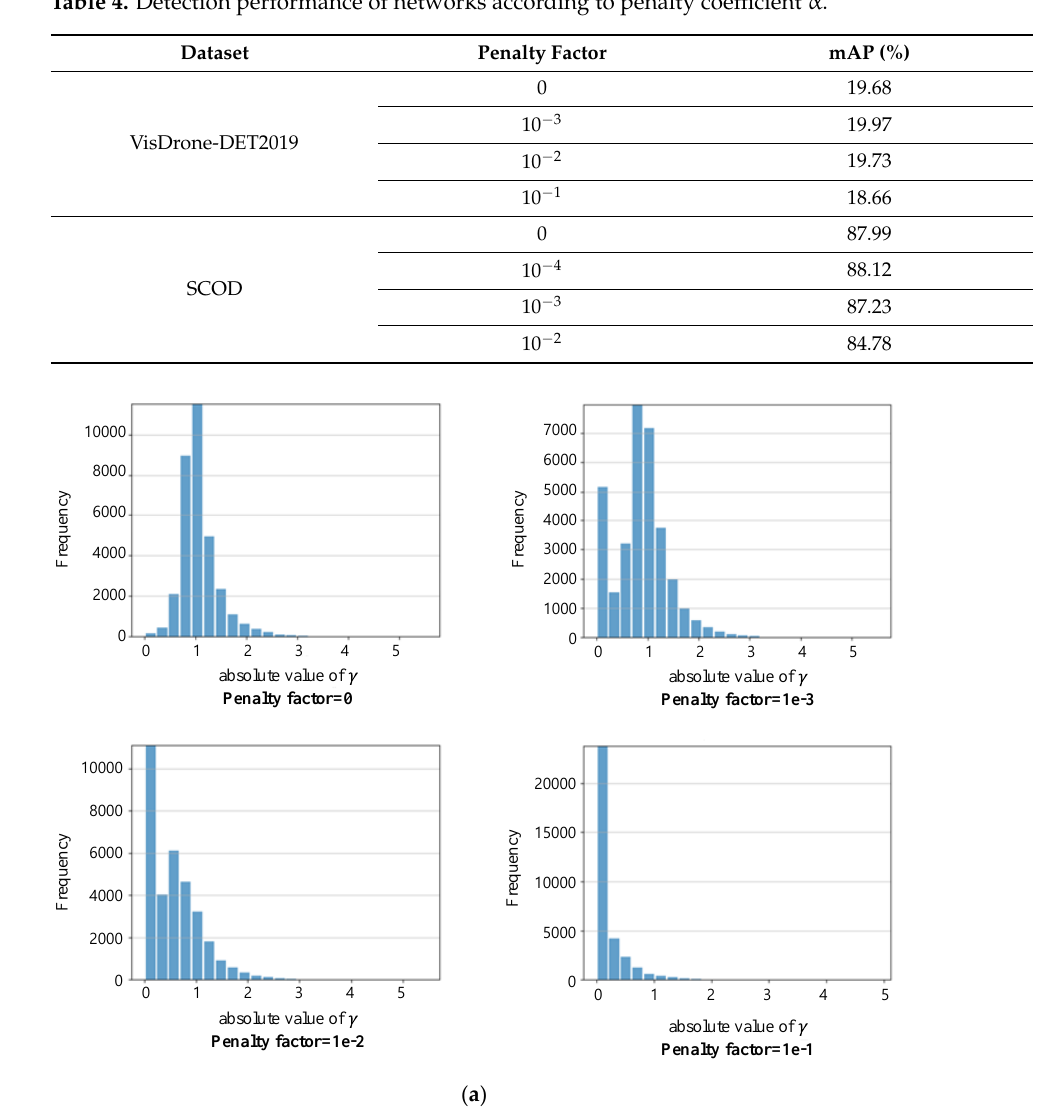
Table 4. Detection performance of networks according to penalty coefficient α .